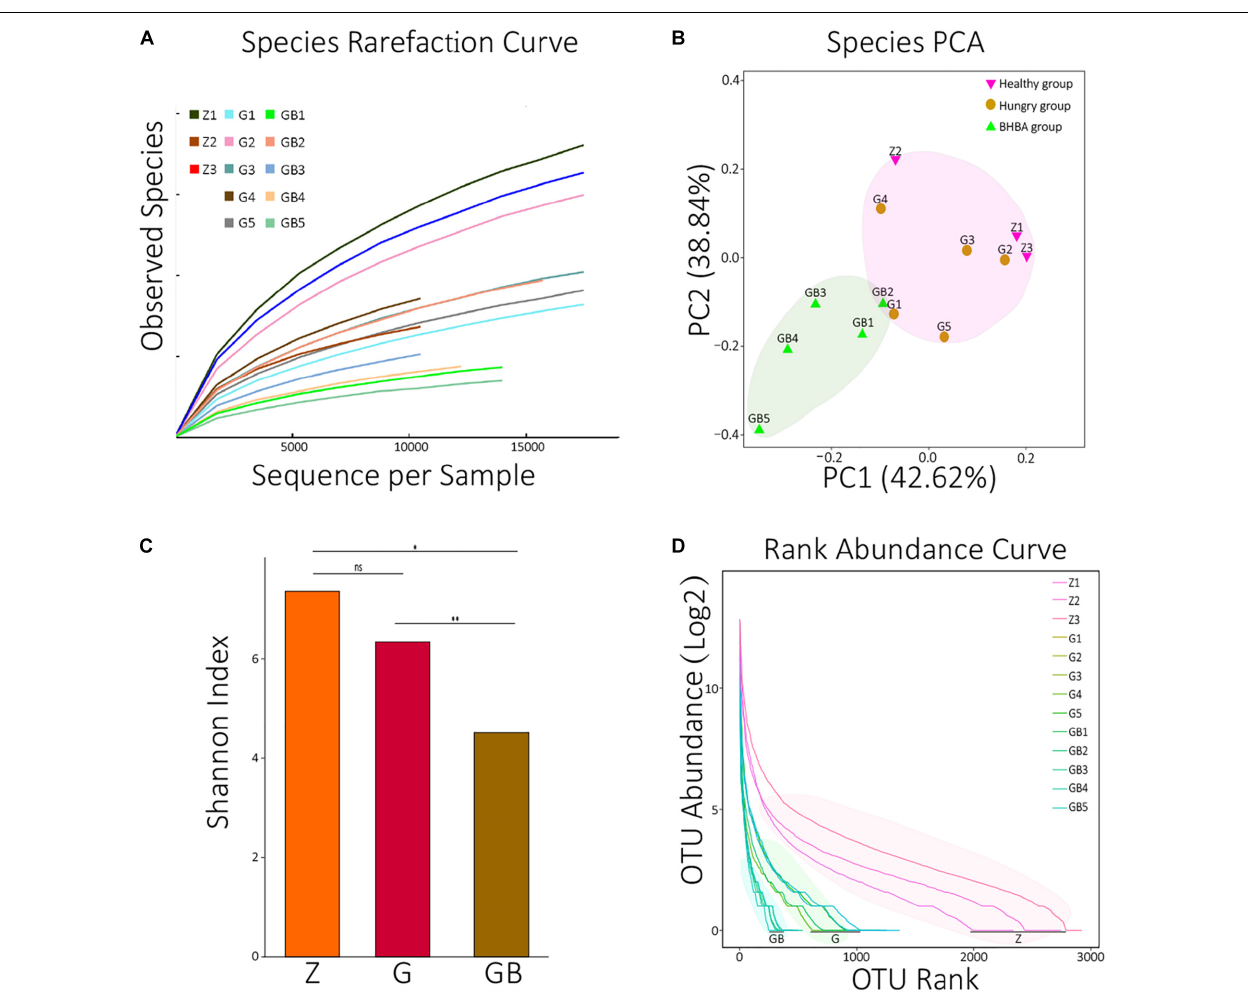
FIGURE 1 | Data processing and diversity analyses. (A) Species rarefaction curves of 13 samples. X: number of randomly selected sequences in each sample, Y: species number observed at corresponding depth. The curvature of the curve represents the possibility that observes new species, the smoother curves, the lower probability of observing new species, and the deeper sequencing depth. (B) PCA (principal component analysis) of species in each sample. The distance between the two samples represents the significance of the difference between them. (C) The average means of Shannon diversity index of each group. ns: non-significant, p > 0.05; *0 . 01 < p < 0 . 05; ** p < 0.01. (D) The rank abundance curves of each sample at the species level. X: taxon arranged in the order of abundance at the species level, Y: the Log2 means which translated from the relative abundance of each species in the corresponding sample. The length of the curve represents the richness of each sample; the curvature of the curve represents the evenness of each sample. OTUs: operational taxonomic units; two sequences with > 97% similarity at the species level were defined as the same